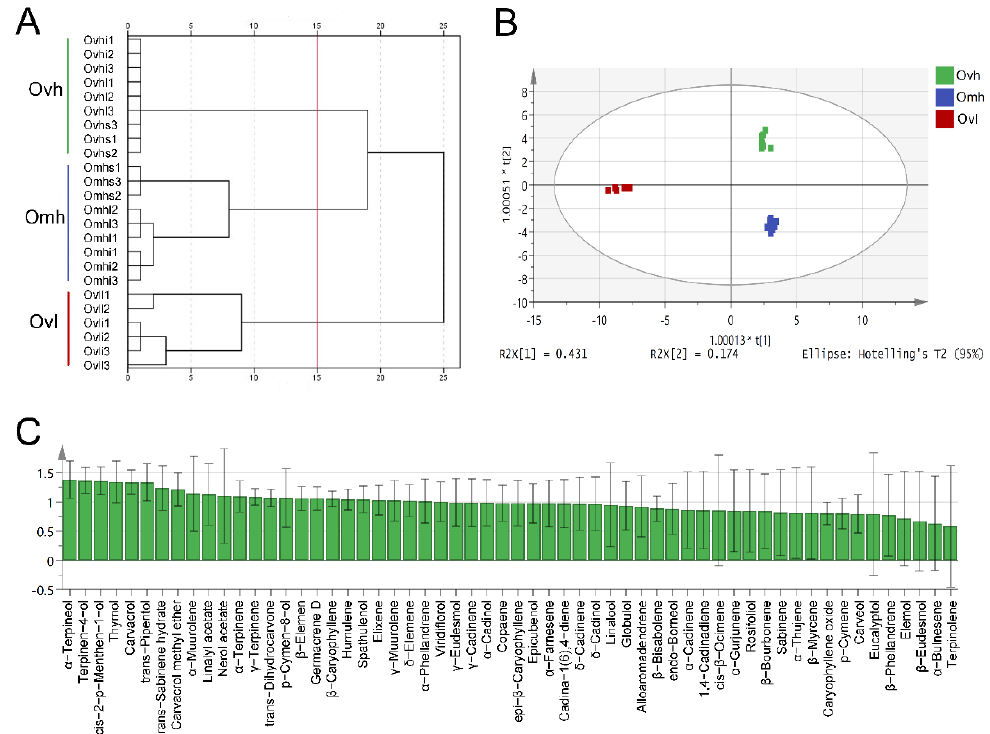
Figure 4. Score plots ( A ), loading plot ( B ), and variable importance in projection (VIP) values ( C ) from orthogonal projections to latent structures discriminant analysis (OPLS-DA) based on the chemical profiles of the three OEO chemotypes.